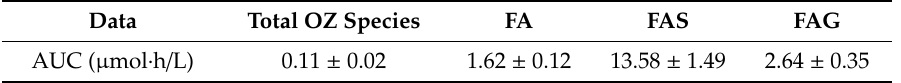
Table 2. The AUC (expressed as µmol·hour/L ) of OZ, FA, and FA conjugates after RBOZ administration.